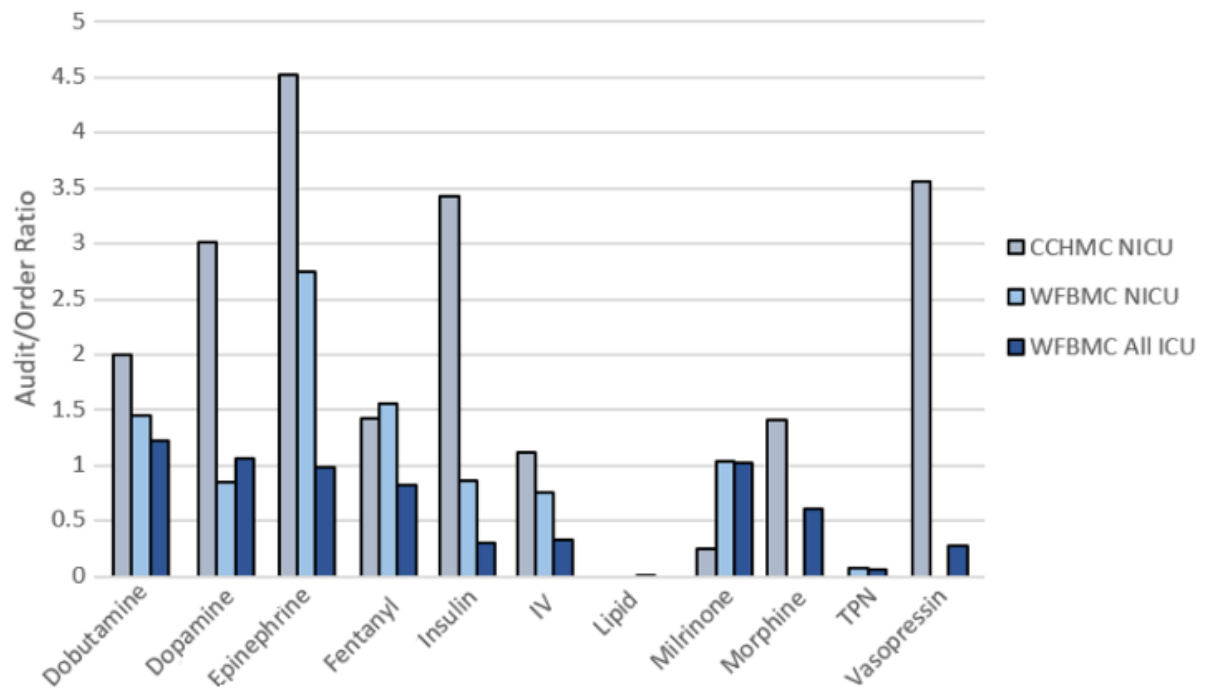
for CCHMC was 4.4. The MAR/(order + audit) ratio for milrinone in the WFBMC NICU was higher than the other medications and departments. This is a result of WFBMC NICU’s practice to verify the rate of milrinone approximately every hour for the entire duration of the